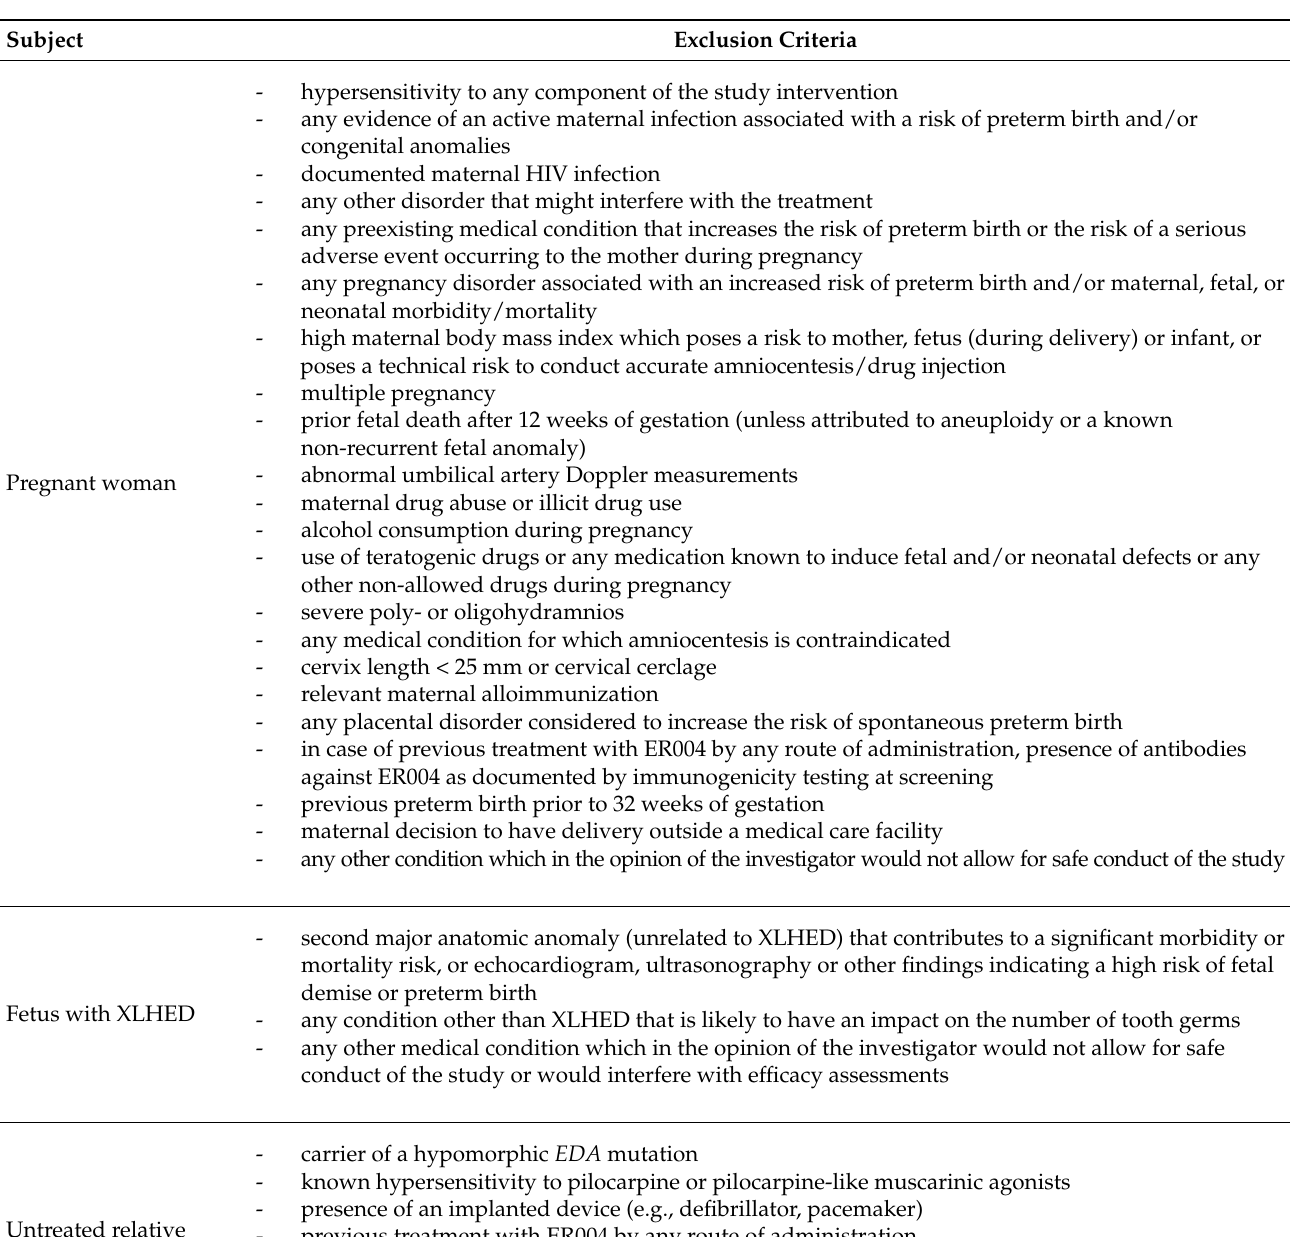
Table 2. Exclusion criteria of the EDELIFE